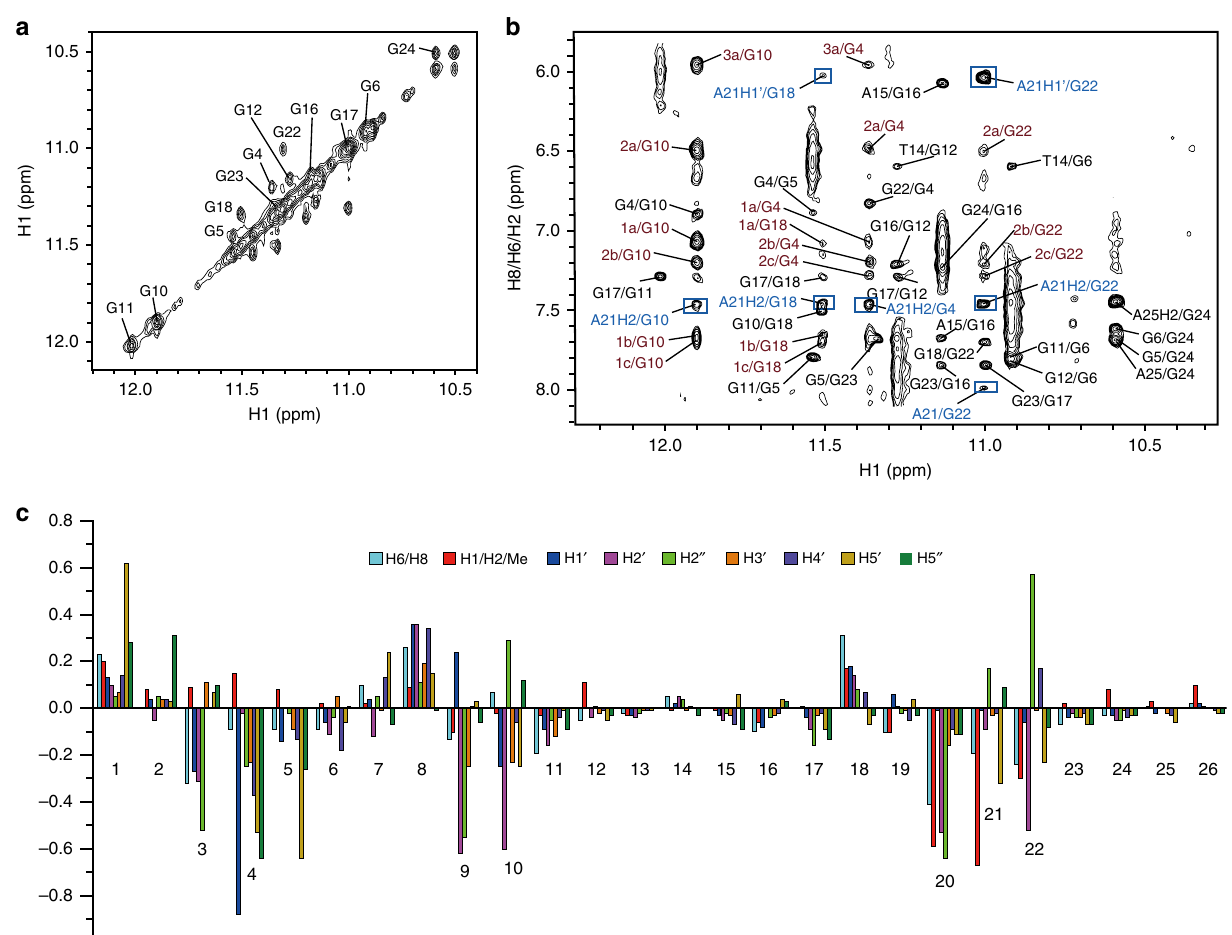
Fig. 3 NMR spectra of the 1:1 Pt-tripod – Tel26 complex. a The expanded H1-H1 region of the NOESY at the 0.5:1 Pt-tripod/Tel26 ratio. Exchange cross- peaks between the free and bound Tel26 are labeled with residue numbers. b The expanded H1-H8/H6/H2 region of the 1:1 Pt-tripod – Tel26 complex. The G x H1-G y H8 cross-peaks of G-tetrads are colored in black. Inter-residue cross-peaks of A21 are framed and colored in blue. Intermolecular cross-peaks of the Pt-tripod and G-tetrad are colored in red. c The chemical shift difference of the protons between the free and bound Tel26 in the 1:1 complex. Condition: 100 mM K + , pH 7.0, 25